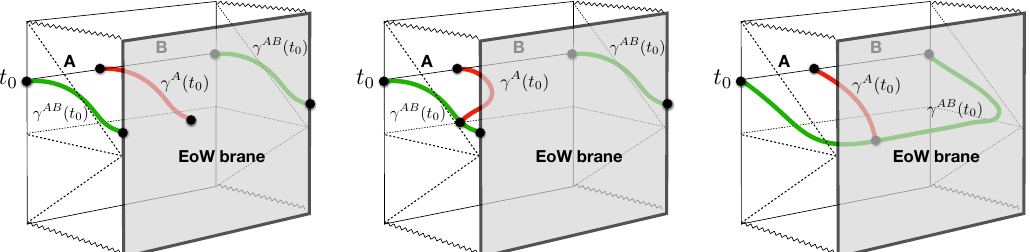
Figure 21 . Phases for the HRT surfaces (cid:13) AB ( t ) (green) and (cid:13) A ( t ) (red) in the holographic pure B-state. Left: for v d t < f‘ A , the corresponding entanglement entropy S op Center: for fL A < v d t < ‘= 2, after a phase transition for (cid:13) A ( t ) itself, S op volume-law; Right: for v d t > ‘= 2, due to the phase transition of the underlying bulk state, i.e. the identi(cid:12)cation surface (cid:13) AB ( t ), (cid:13) A ( t ) is forced to jump discontinuously to be short-ranged.